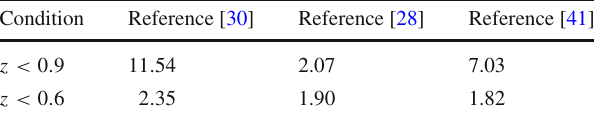
Table 3 χ 2 /d.o.f. for the LDMEs taken from Refs. [28,30], and [41], respectively Condition Reference [30] Reference